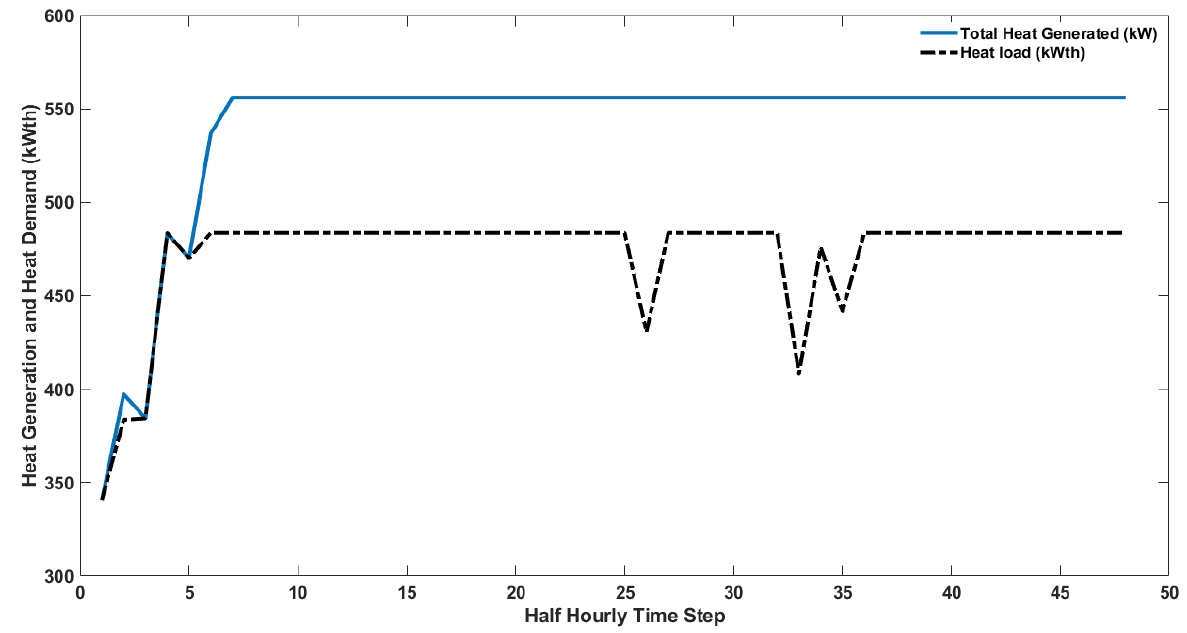
Figure 17. Grid participation, BESS SoC, grid tariff, and BESS charge/discharge command (scenario 4).